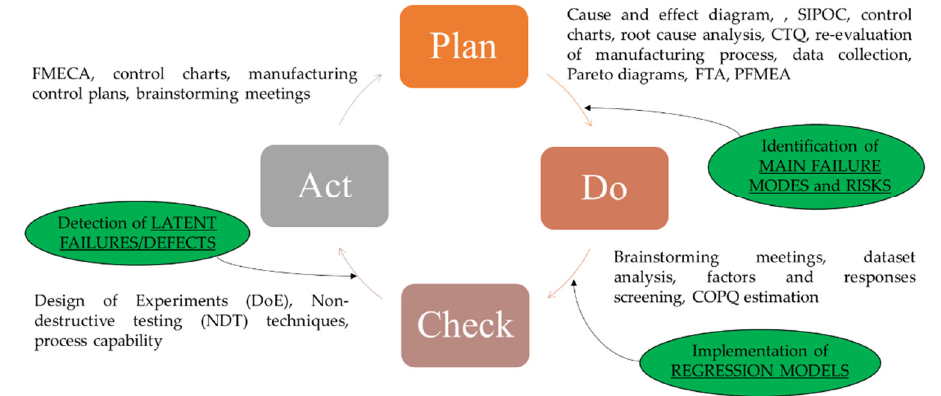
Figure 8. Plan-do-check-act (PDCA) cycle for the continuous improvement in US probes manufacturing process.